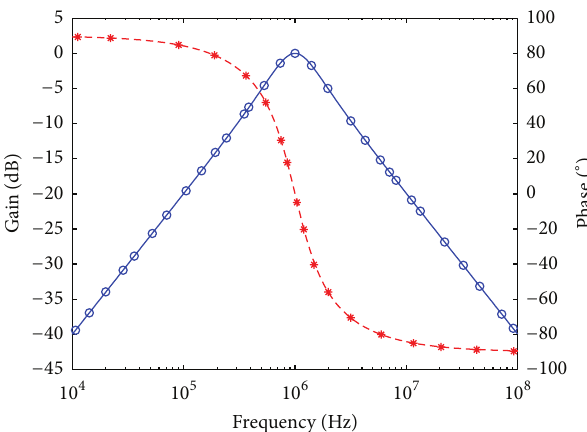
Figure 7: Simulated gain-frequency and phase-frequency responses of noninverting bandpass filter at 𝑉 𝑜1 ( ∘ : simulated gain; ∗ : simulated phase; — and ---: theoretical curves).